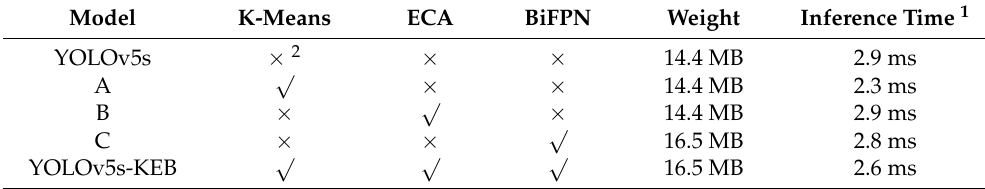
Table 3. Comparison of parameters of each